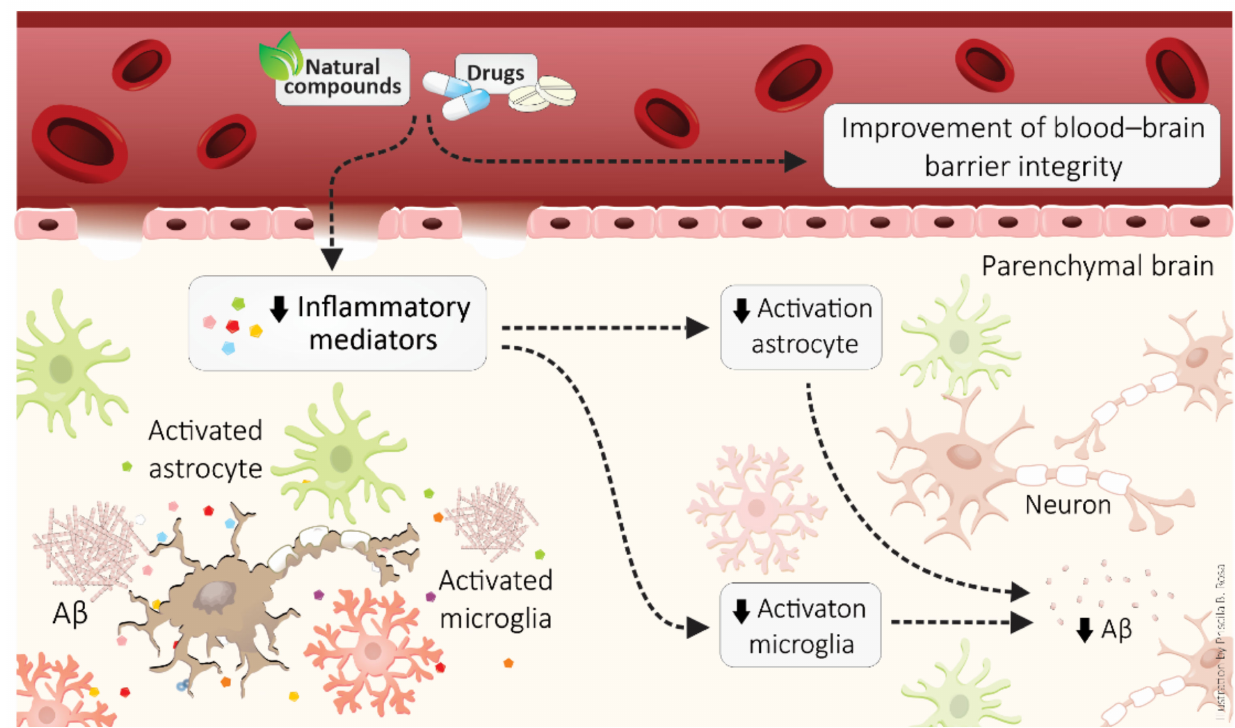
Figure 3. Anti-inflammatory approaches, such as drugs and natural compounds, in Alzheimer’s disease. Anti-inflammatory therapeutic strategies improve the blood–brain barrier and neuroinflammation, decreasing activation of astrocytes and microglia as well as generation of pro-inflammatory